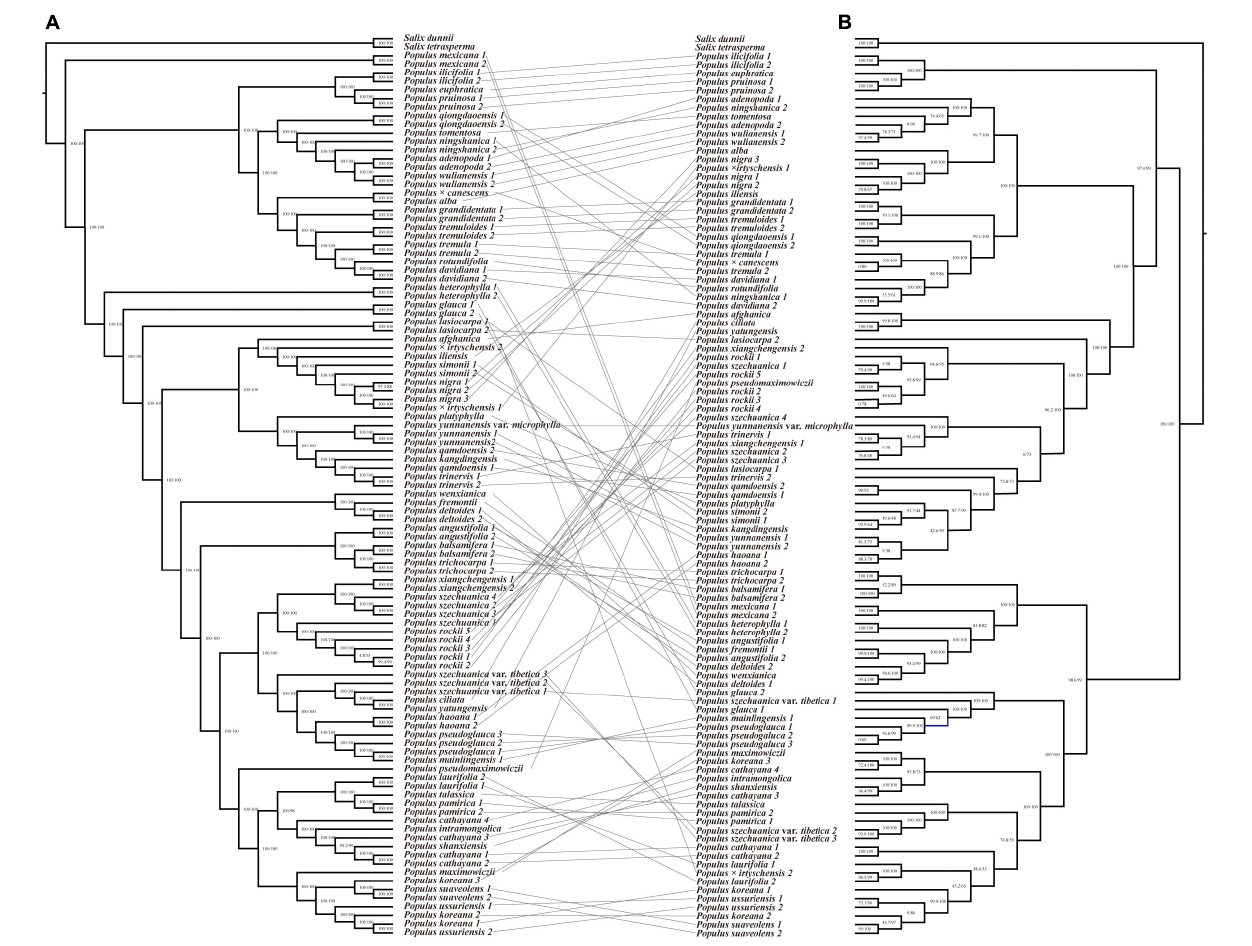
FIGURE 2 | Cytonuclear conflicts among different Populus lineages. The taxa that encountered cytonuclear conflicts are linked by black lines. (A) Phylogenetic relationship of the genus Populus reconstructed by IQ-TREE based on 12,916,788 nuclear SNPs. (B) Phylogenetic relationship of the genus Populus reconstructed by IQ-TREE based on complete chloroplast genomes. The values indicate the supports of SH-aLRT bootstrap (Alrt) and Ultrafast bootstrap (UFBoot).